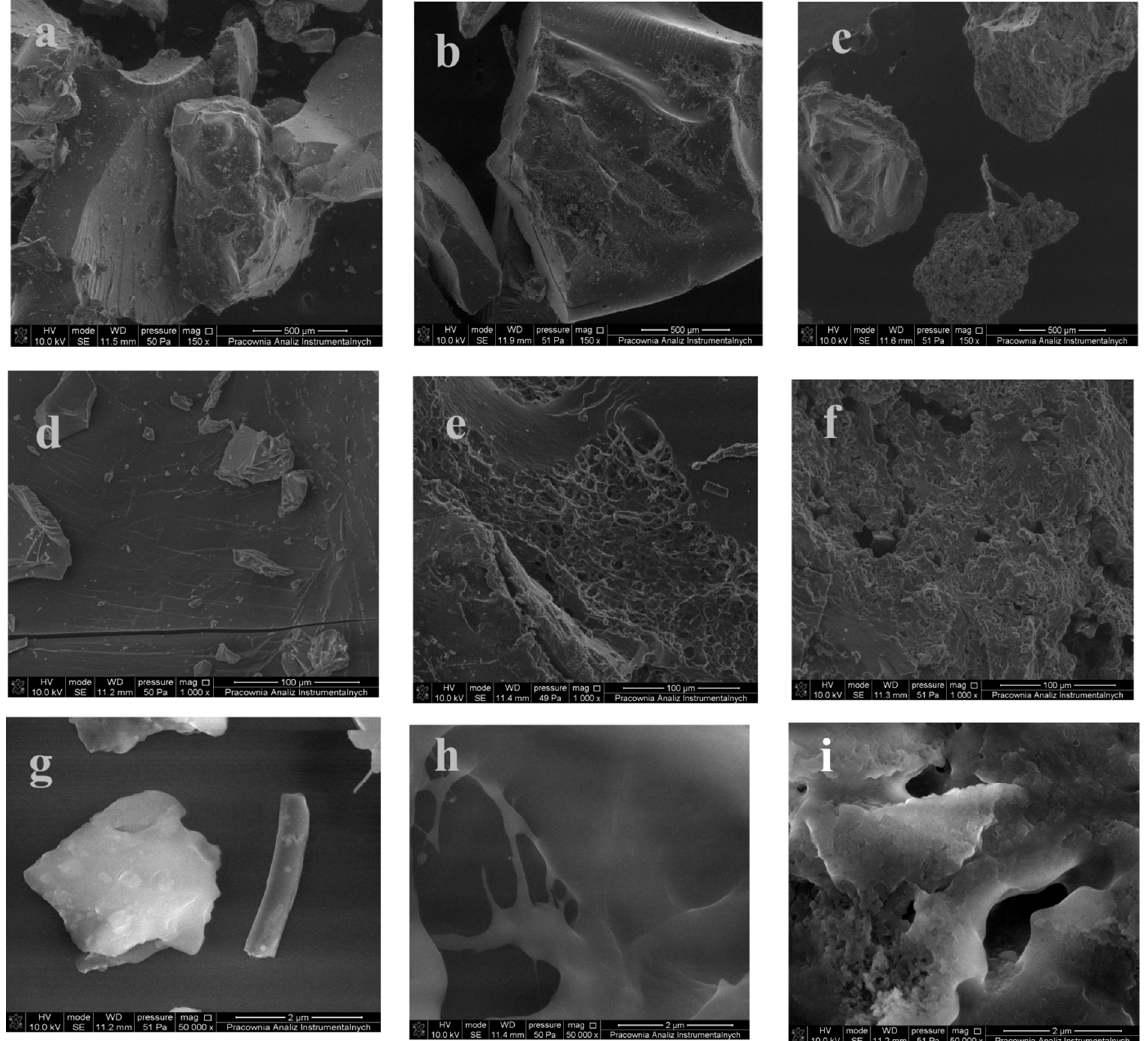
Figure 5. SEM images at 150× magnification of substances: ( a ) PVA/PS-g-P(AA-co-AM-co-AMPS), ( b ) PVA/PS-g-P(AA-co- AM), ( c ) SS-g-P(AA-co-HEMA), 1000× magnification of substances ( d ) PVA/PS-g-P(AA-co-AM-co-AMPS), ( e ) PVA/PS-g- P(AA-co-AM), ( f ) SS-g-P(AA-co-HEMA), 50,000× magnification of substances ( g ) PVA/PS-g-P(AA-co-AM-co-AMPS), ( h ) PVA/PS-g-P(AA-co-AM), ( i ) SS-g-P(AA-co-HEMA).